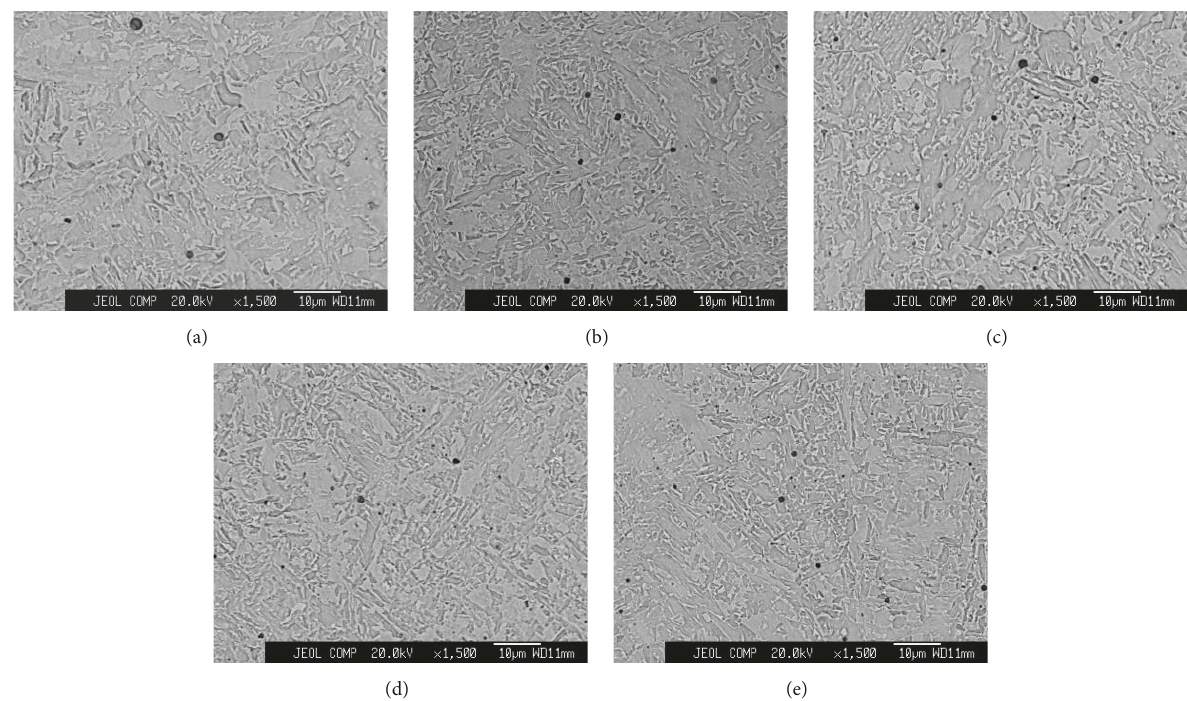
Figure 5: Typical SEM images of welded metals with different REE contents: (a) REE-free, (b) 0.3 wt.%, (c) 0.5 wt.%, (d) 0.7 wt.%, and (e) 1.0 wt.%.